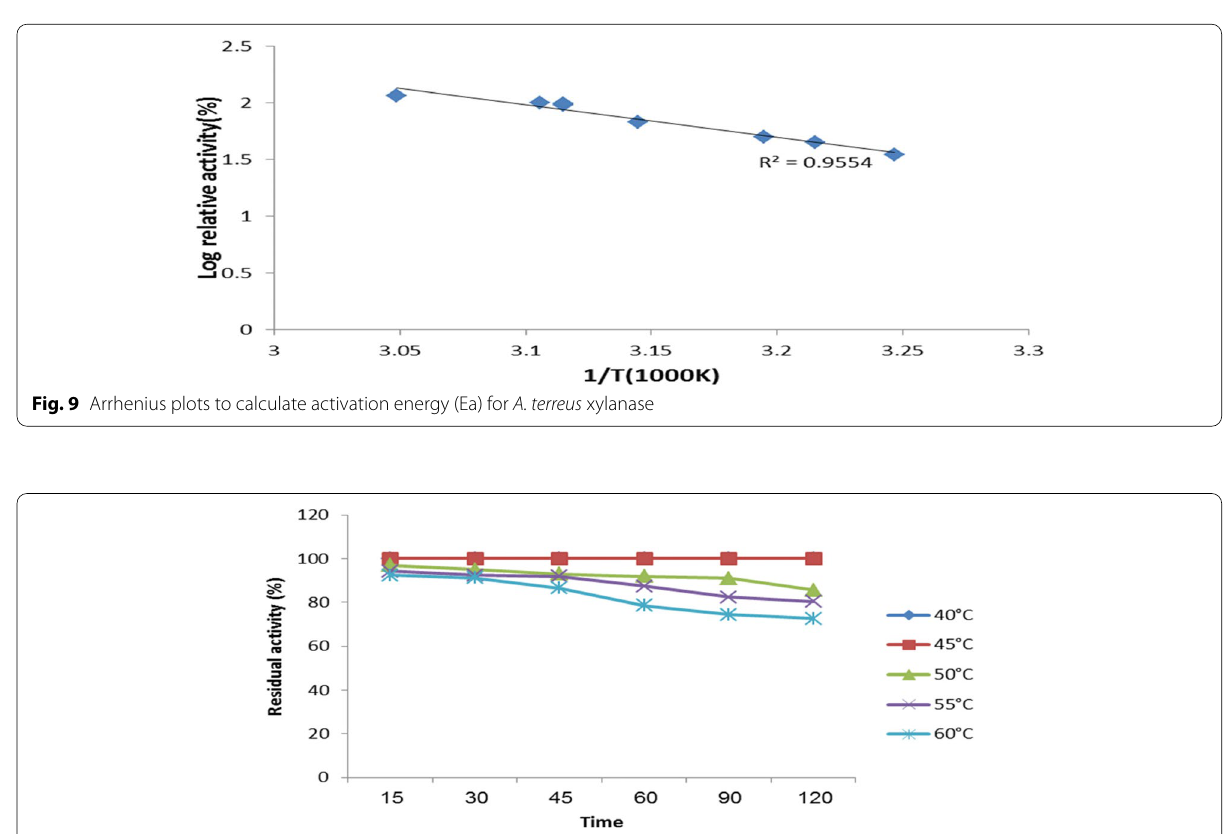
Fig. 10 Temperature‑stability profile for A. terreus